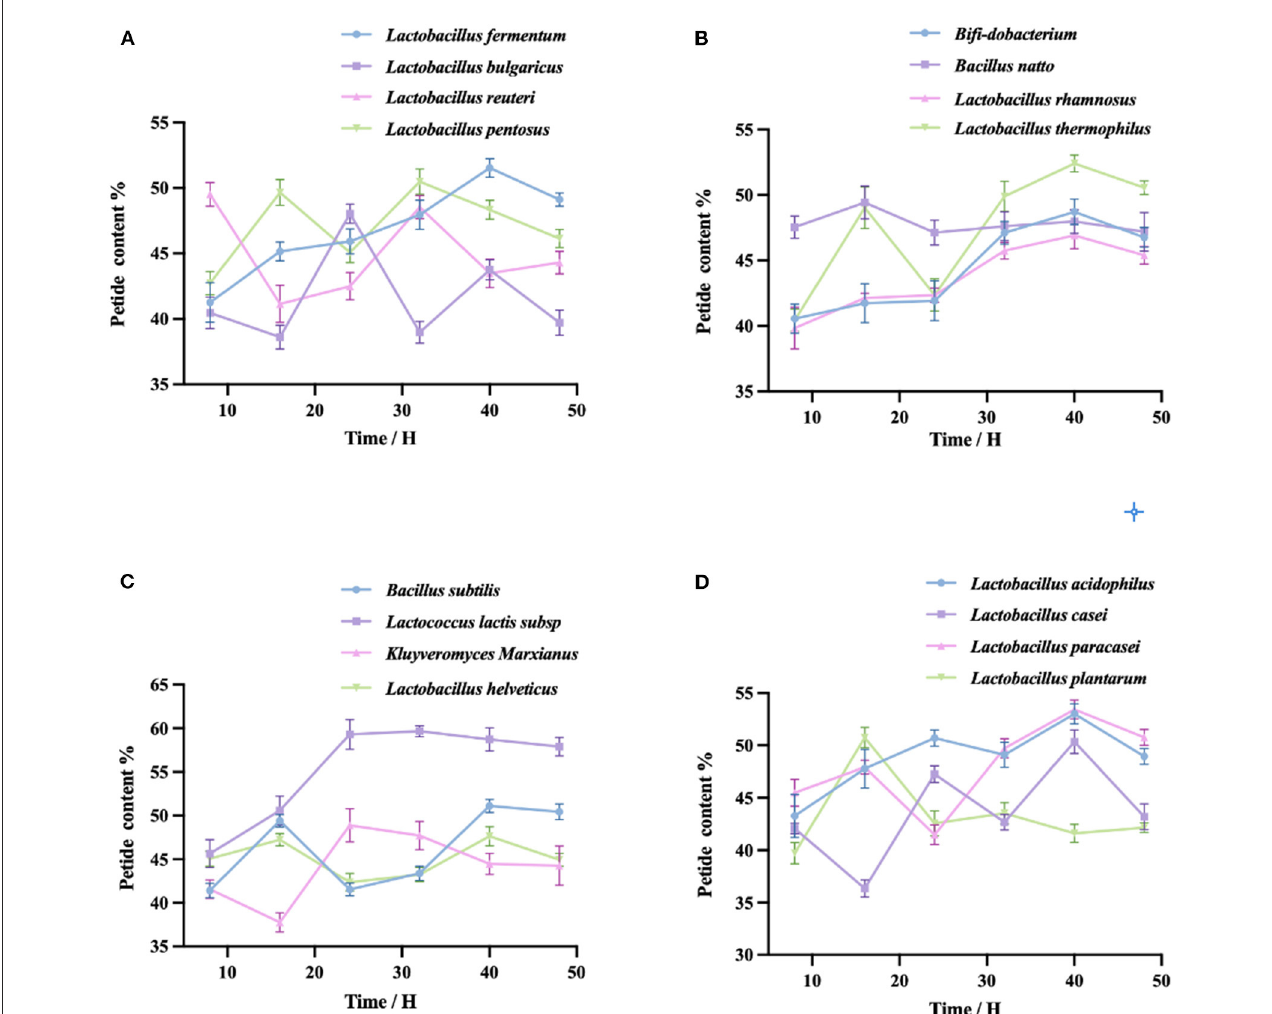
FIGURE2 (A–D) Fermentation of QF with each of the 16 bacterial taxa. The peptide content was measured by the Biuret method. Variation in peptide yield (%) during the fermentation of quinoa by different taxa. Values are expressed as the mean ± standard deviation of three